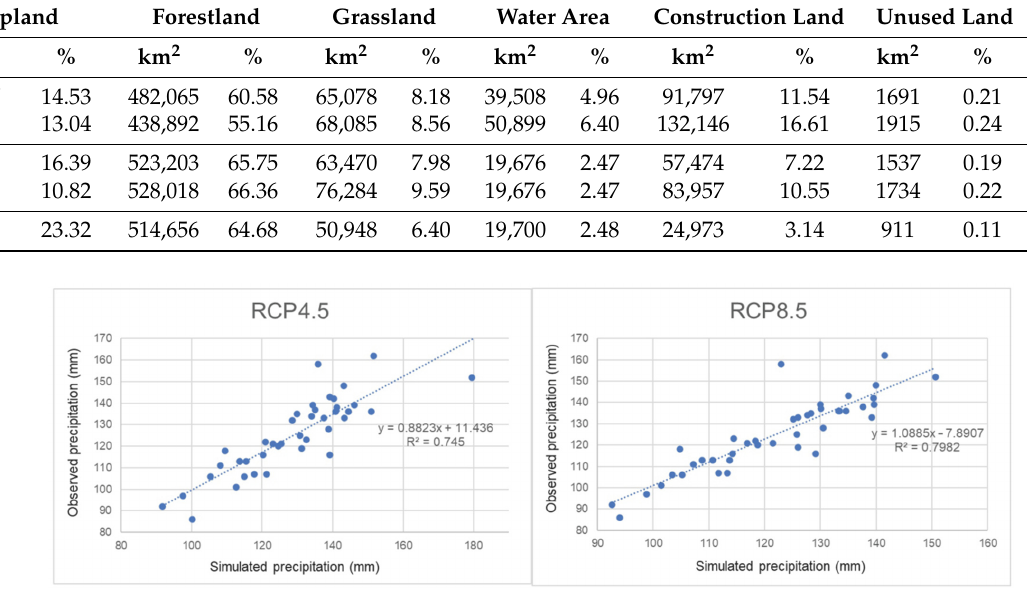
Figure 3. Comparison between the observed and simulated National Center for Atmospheric Prediction (NCEP) monthly mean precipitation for the validation period (1985–2000) at 50 weather stations. In 2030, the soil erosion of the cropland, forestland and grassland in the No LUC pattern was 240 t km − 2 , 193 t km − 2 and 370 t km − 2 under the RCP4.5 climate scenario and 261 t km − 2 , 229 t km − 2 and 434 t km − 2 under the RCP8.5 climate scenario, respectively. In the RCP4.5 climate scenario was 274 t km − 2 , 221 t km − 2 and 421 t km − 2 , respectively;